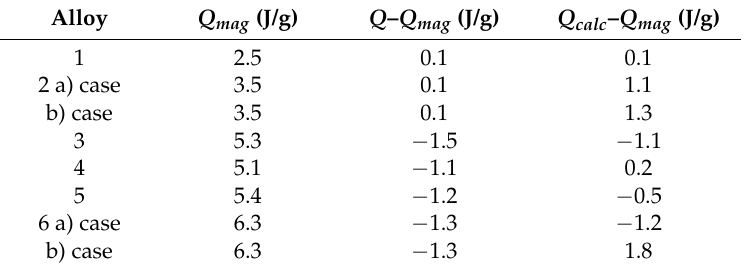
Table 2. Magnetic contribution to the transformation heat ( Q mag ), and heat differences between the total transformation heat and magnetic contribution calculated for both experimental ( Q ) and calculated ( Q calc ) total